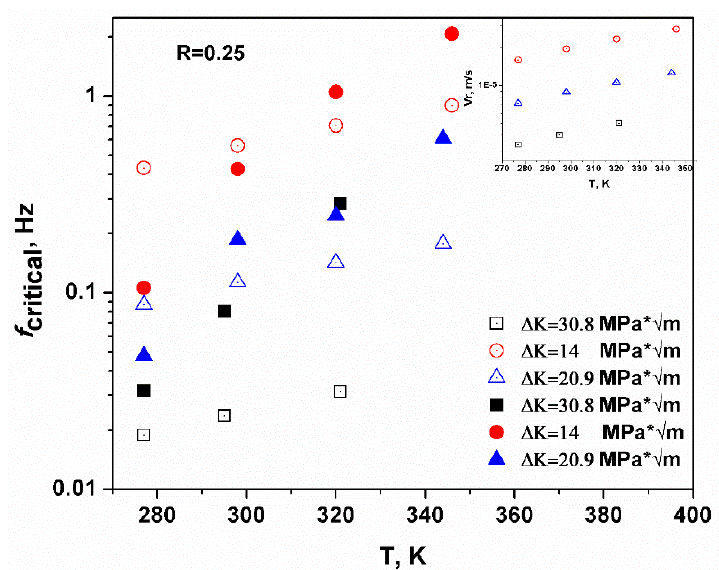
Figure 2. The predicted and tested critical loading frequency versus temperature, where the filled symbols are the tested values in the HY-130 steel, and the open symbols are the predicted values. Both sets of data showed the same tendency, which verified the predictive capability of the model. The inset predicted the hydrogen movement velocity at different temperatures and showed that hydrogen movement was enhanced by temperature [33].